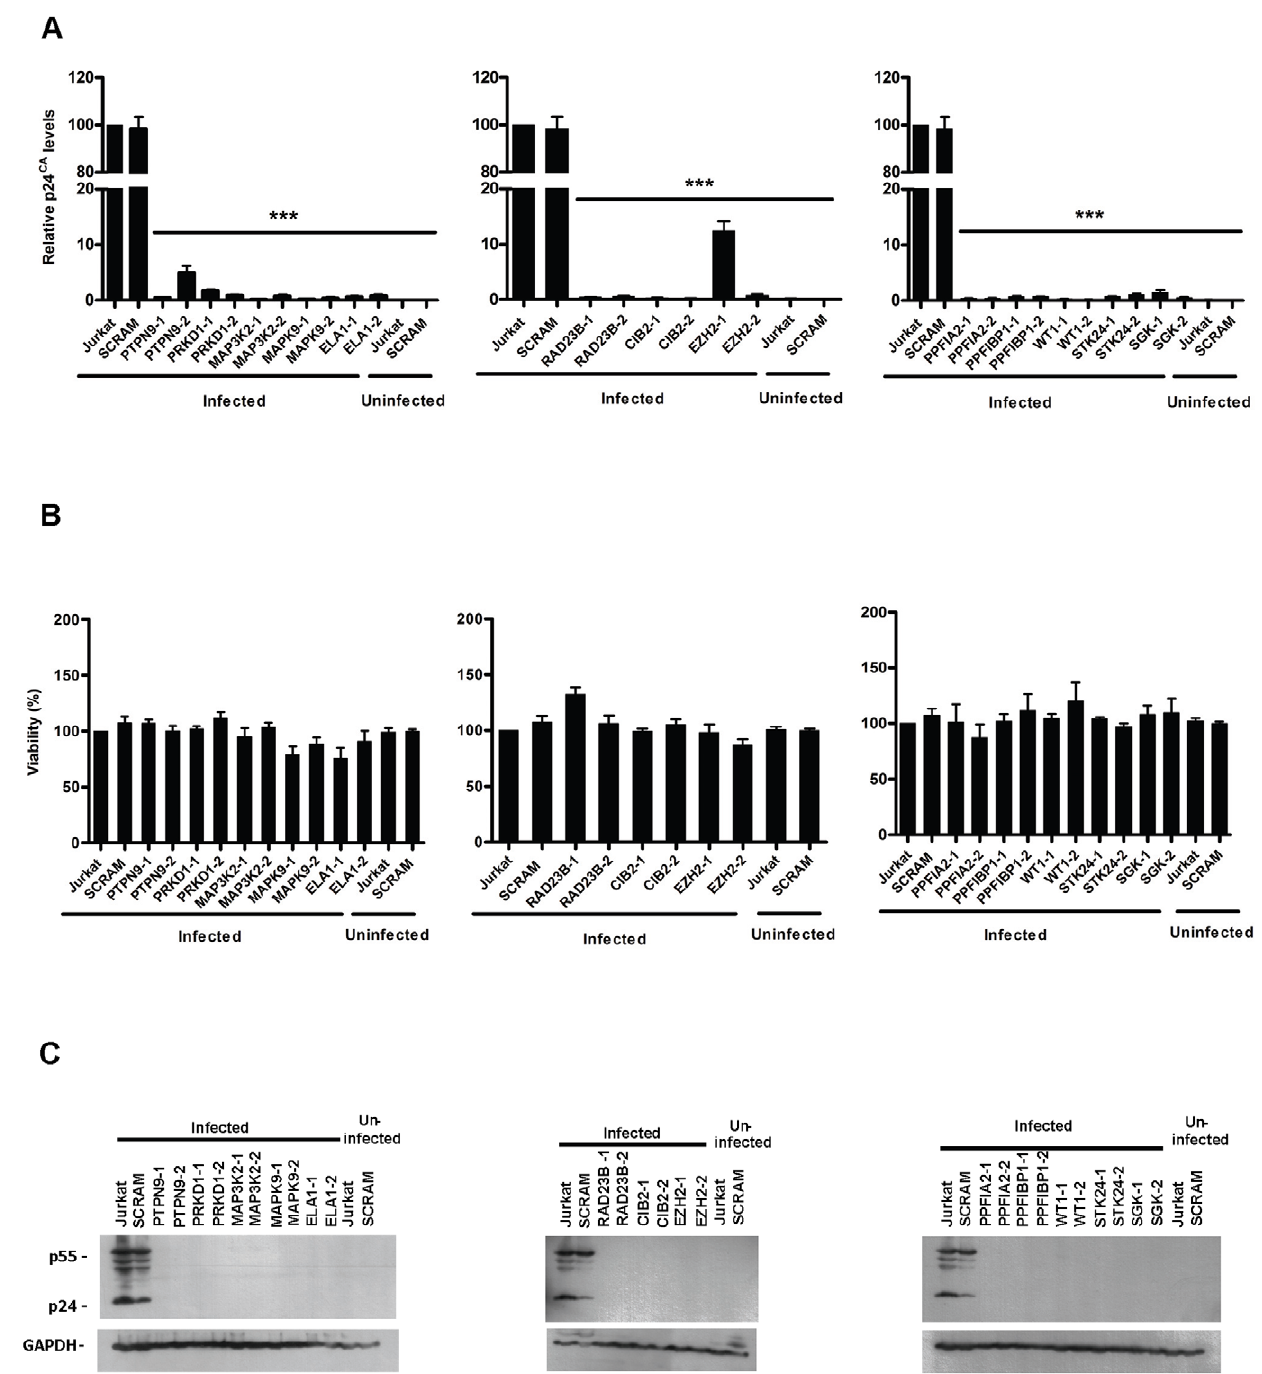
Figure 2. shRNA clones are resistant to HIV-1 replication. A . Two different shRNA clones for each target gene were infected with HIV-1 NL4-3 (MOI of 1) and after 7 days of infection, HIV-1 replication was measured by p24 CA levels in the cell culture supernatant. Values are relative to Jurkat cells infected with HIV-1 NL4-3 and represent the mean 6 SEM ( n =6). *** corresponds to P , 0,0001. B . Viability of shRNA clones after 7 days of infection with HIV-1 NL4-3 . Values are relative to Jurkat cells infected with HIV-1 NL4-3 and correspond to mean 6 SEM ( n =4). C . Immunoblotting of intracellular Gag protein in different shRNA clones after 7 days of HIV-1 NL4-3 infection (MOI of 1). This figure is representative of three independent experiments. doi:10.1371/journal.pone.0009276.g002 black bars). To assess whether by using VSV-G-pseudotyped HIV- 1 vectors we were overcoming an entry defect in Jurkat by flow cytometry showed similar fluorescence results compared to knockdown clones, similar experiments were performed with a the control shSCRAM indicating that in all Jurkat-knockdown- gp120-pseudotyped lentiviral vector. Results from transduction cells HIV-1 proviral vector was efficiently integrated (Figure 4, PLoS ONE |